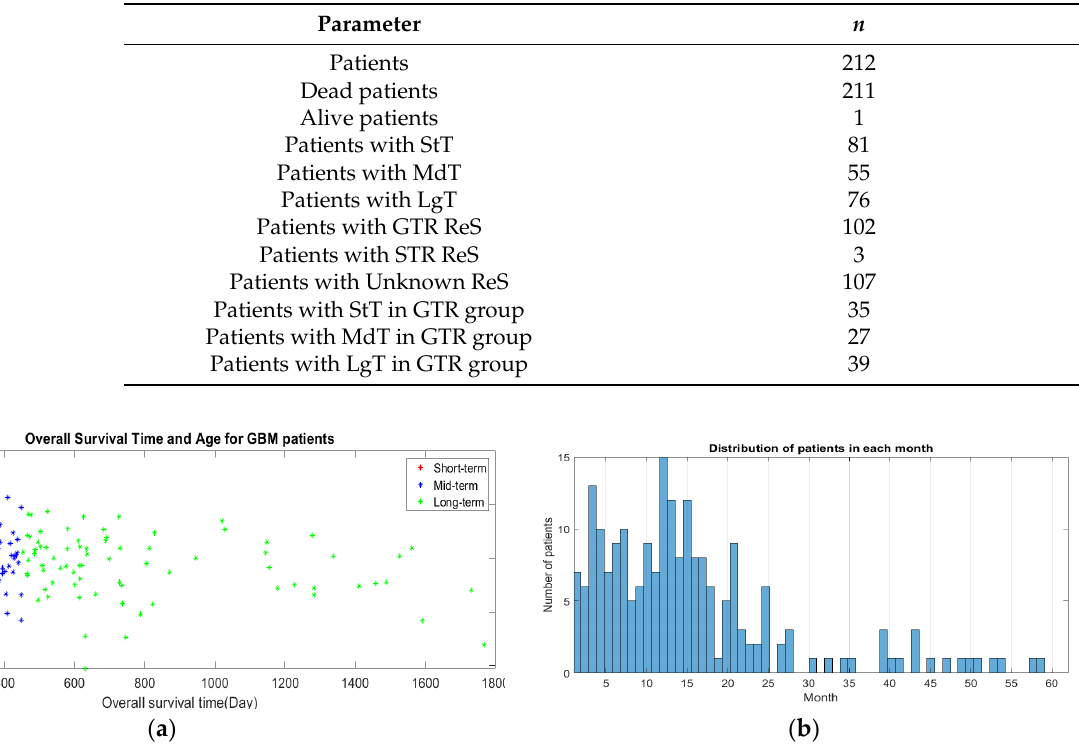
Figure 3. Survival distribution for BraTS 2019 dataset, ( a ) patients’ age and the overall survival time, ( b ) number of patients in each month.